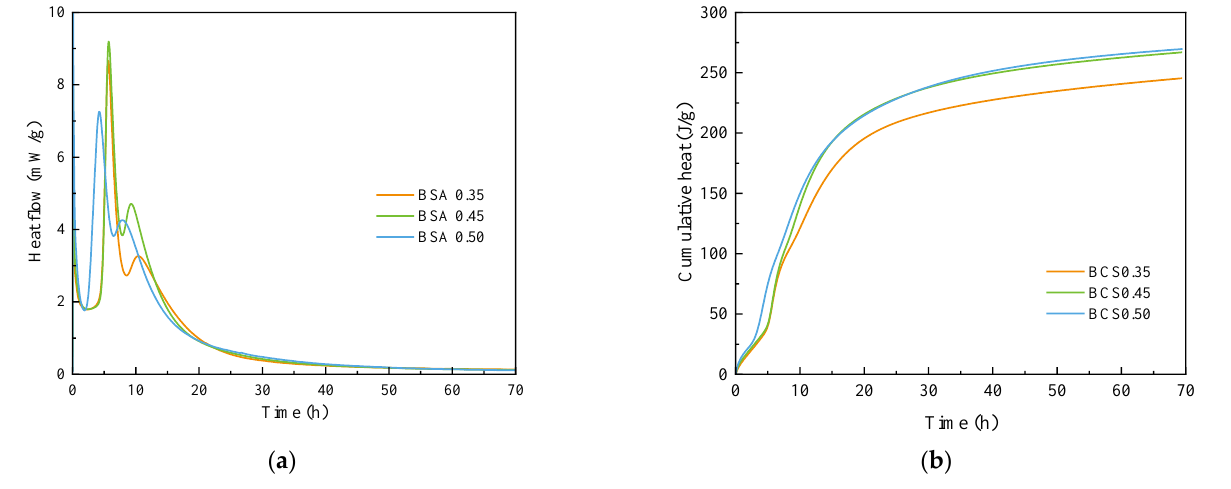
Figure 2. Heat flow ( a ) and cumulative heat curves ( b ) of BCSA cement pastes within 72 h.